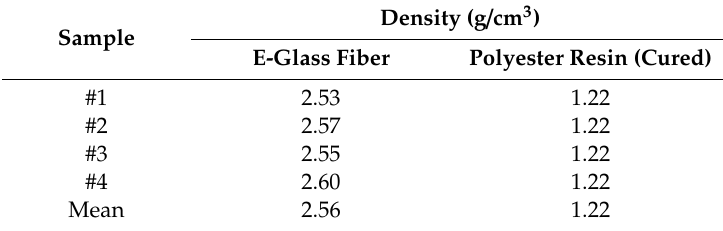
Table 7. Measurement of specimen densities using a hydrometer. Sample